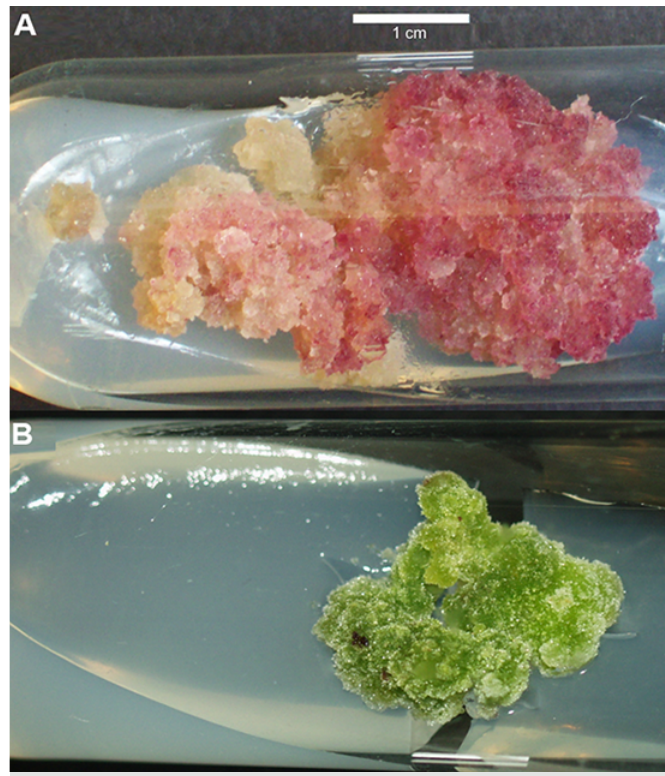
Fig. 1 Callus cultures after 15 passages of subculturing ( A ) RCL tissue grown on Murashige and Skoog medium, ( B ) GCL tissue grown on Woody-Plant medium. Both media were supplemented with 2,4-di- chlorophenoxyacetic acid (l mg L −1 ), α-naphthalene acetic acid (l